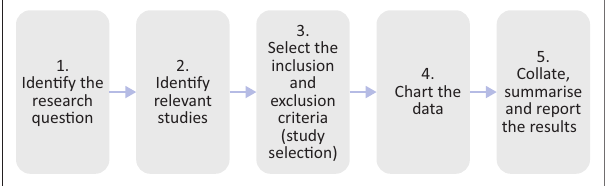
FIGURE 1: The five-step study process based on the Joanna Briggs Institute